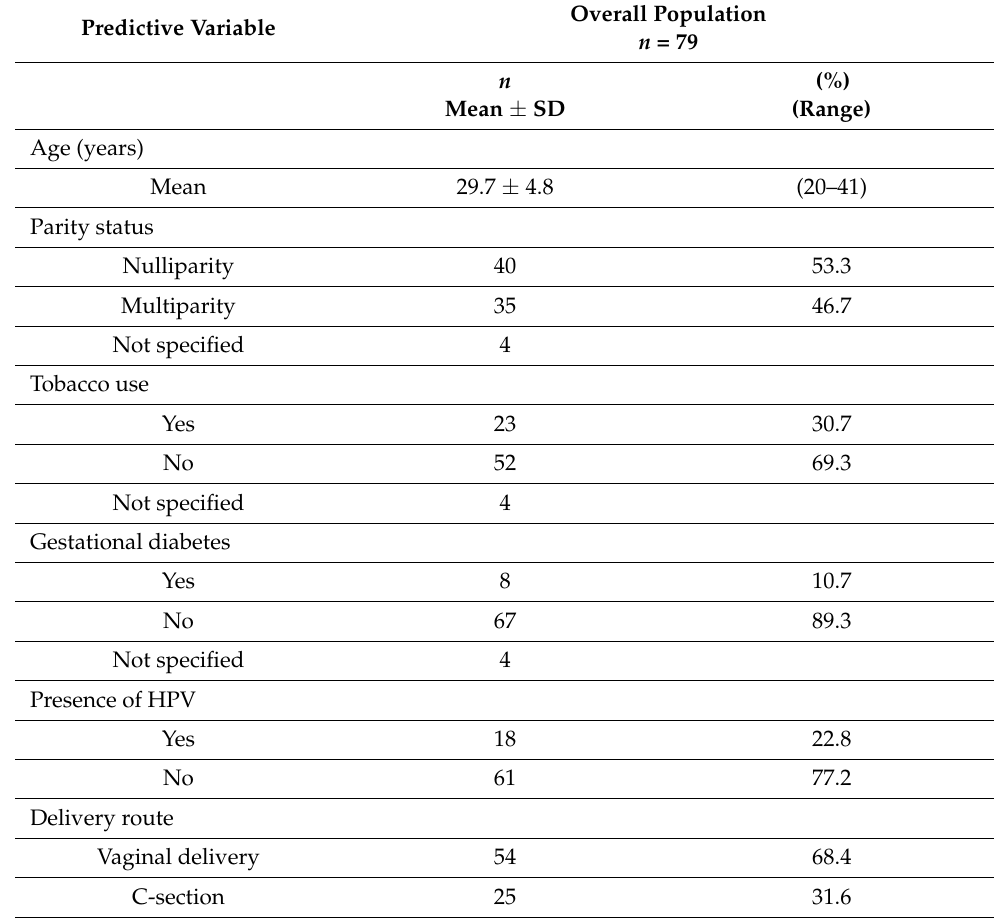
Table 1. General patient characteristics.